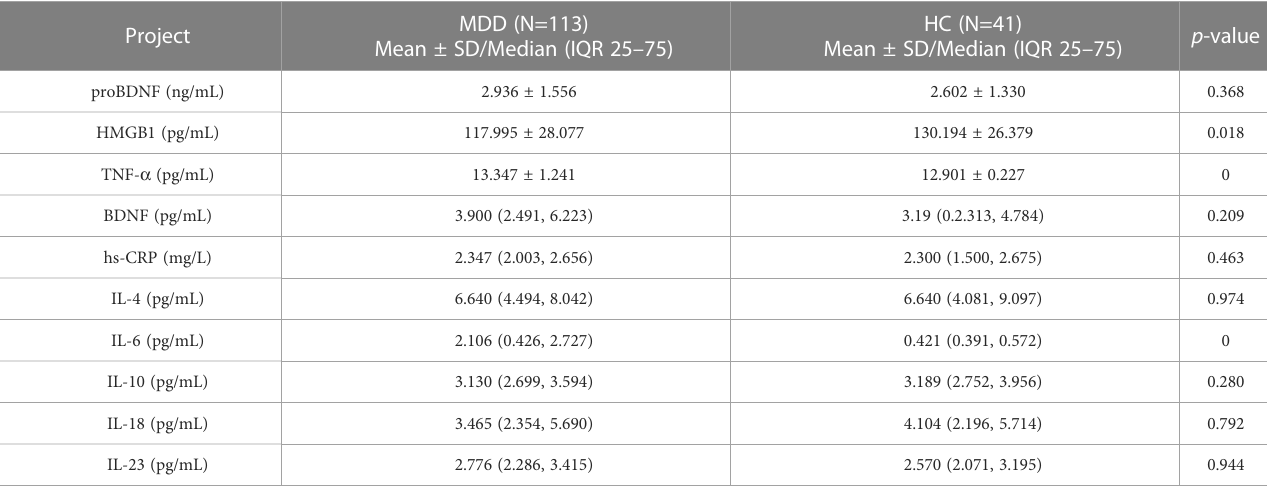
TABLE 2 Comparison of biomarkers between the MDD group and HC